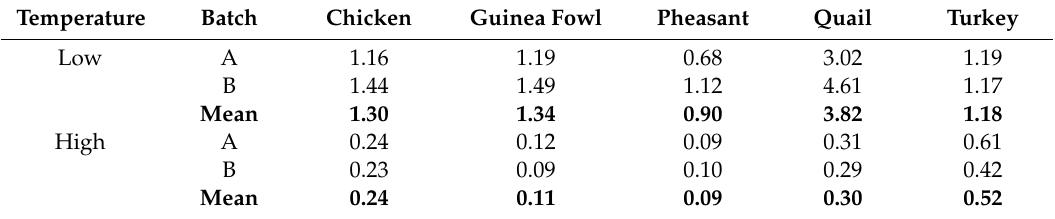
Table 5. Matrix-specific multiplication factors to predict the concentration of meat from five poultry species in unknown emulsified type sausages under two temperature conditions.